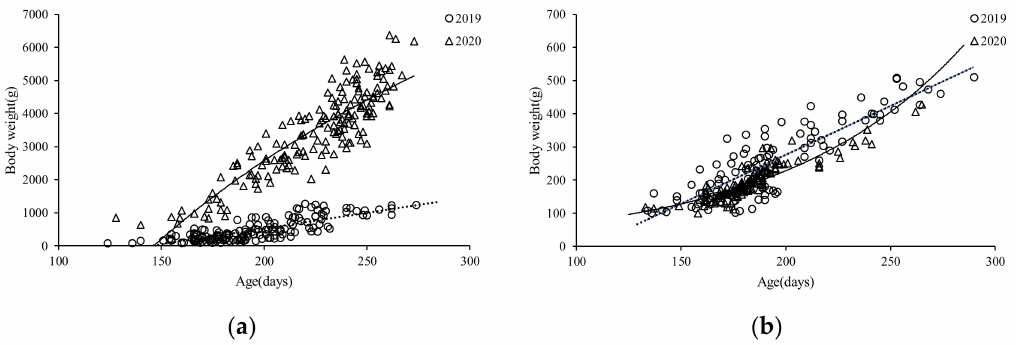
Figure 10. The relationship between BW–age for S. oualaniensis in the northwest Indian Ocean in different years: ( a ) female; ( b )